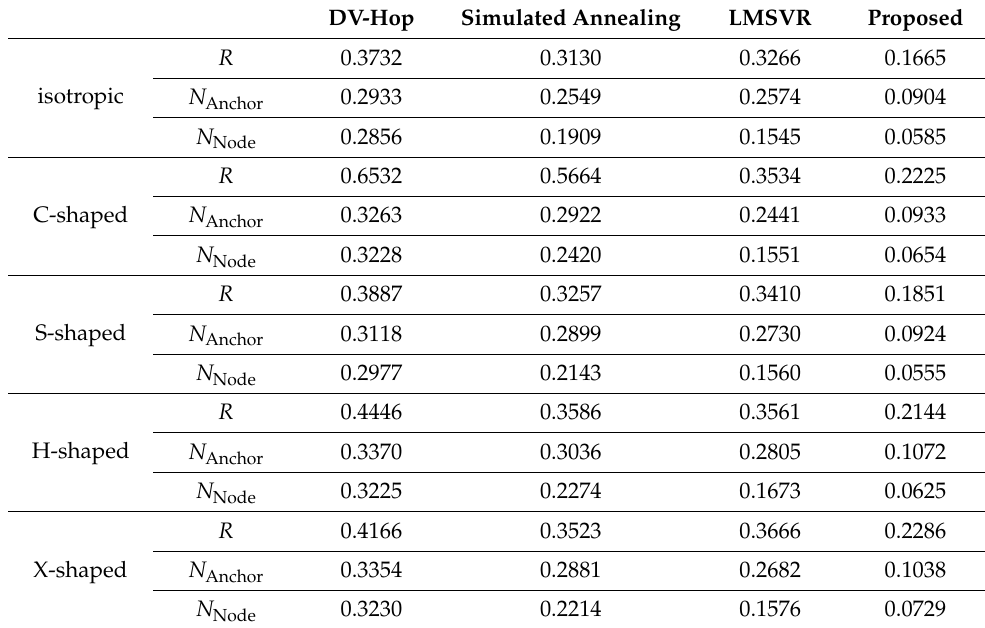
Table 3. Comprehensive performance of algorithms in different